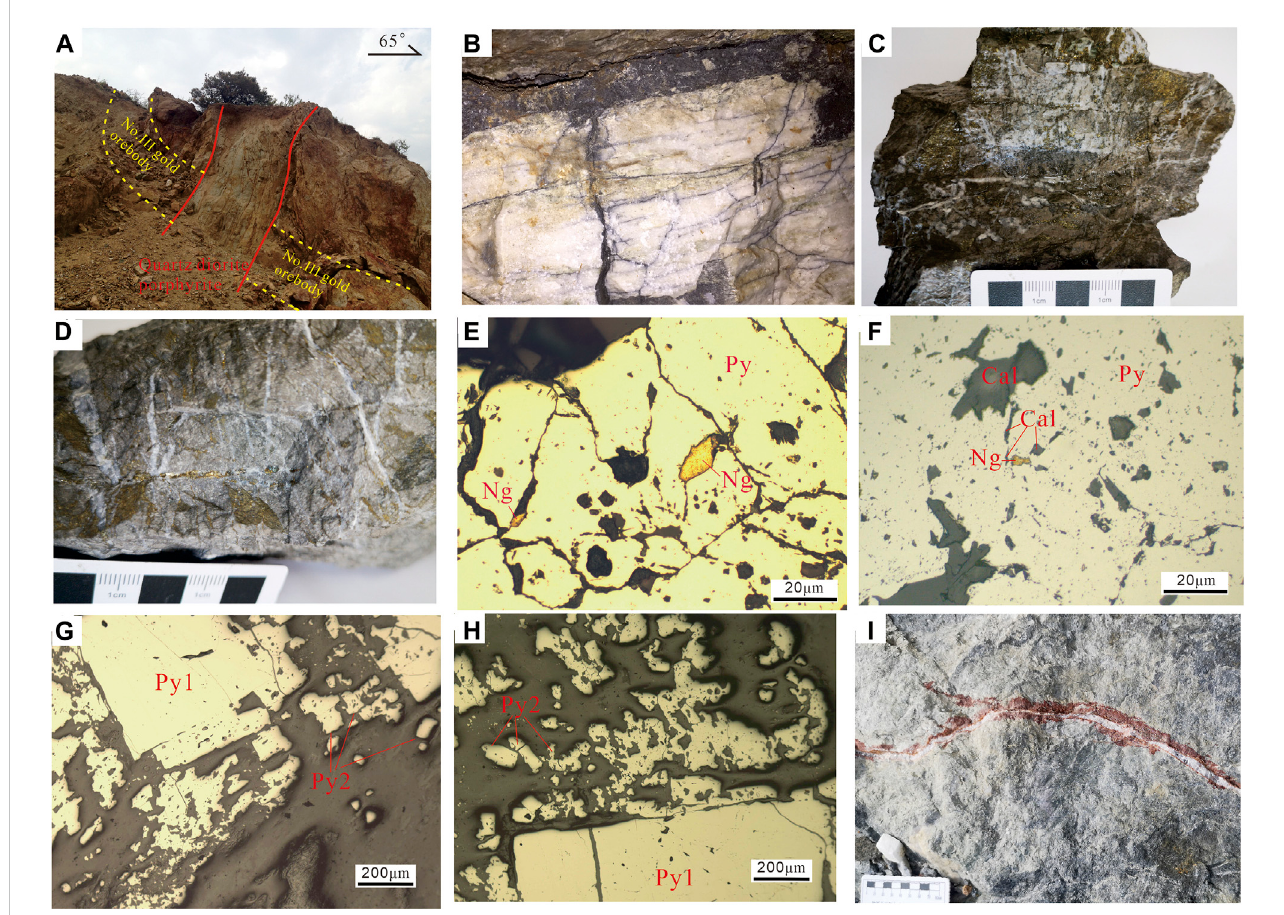
FIGURE 4 PhotographsshowingmineralassemblagesandmineralizationstagesintheYangjiakuanggolddeposit (A) Quartzdioriteporphyritedykecuttingthrough the gold orebody; (B) Disseminated-type ore; (C,D) Veinlet-type ore; (E,F) Irregular native gold inclusions within Py; (G,H) Micrographs of Py1 and Py2; (I) Quartz and calcite vein; Mineral abbreviations used are as follows: Py, Pyrite; Cal, Calcite; Ng, Natural